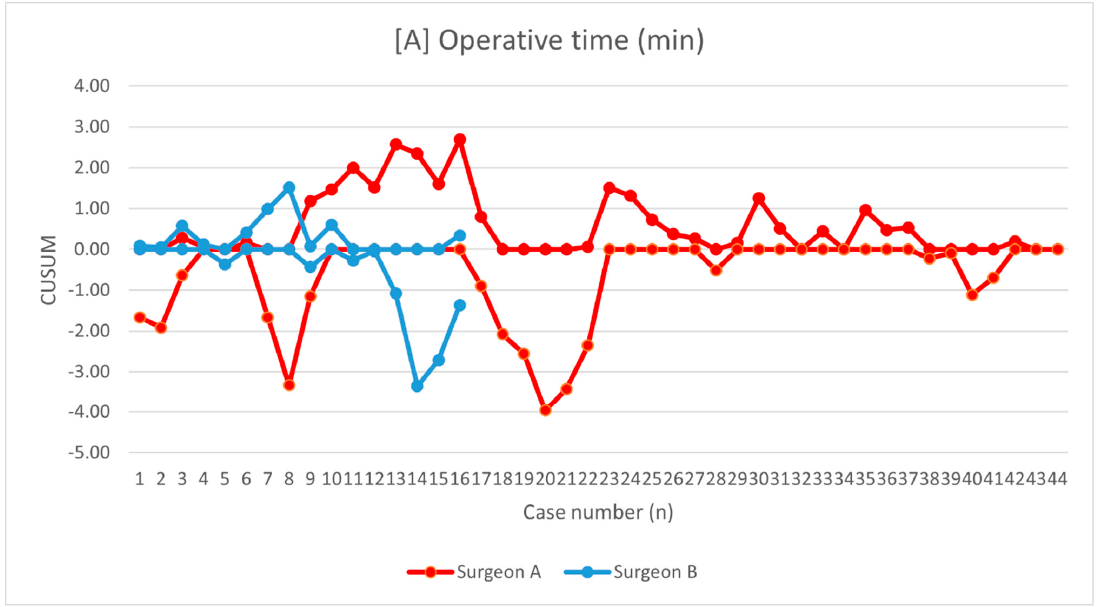
Figure 2. Chart showing the operative time presented as cumulative sum analysis separately for surgeons A and B.